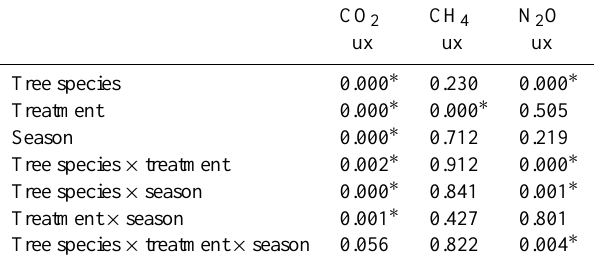
Table 4. Significance of the impacts of tree species, litter removal treatment, season, and their interactions on GHG